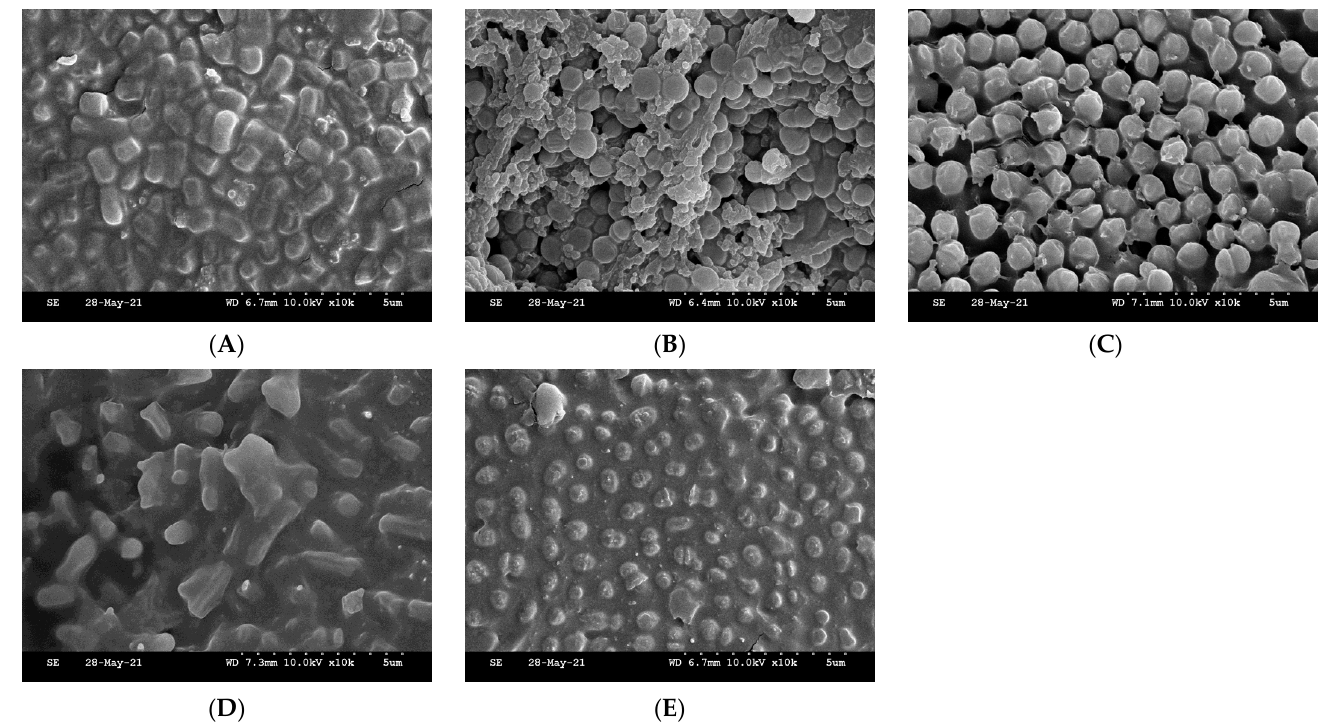
Figure 1. Representative scanning electron micrographs (SEM) at 10,000× of probiotic bacterial cells after freeze-drying owing to the addition of 3% low molecular weight collagen-peptide (LCP). ( A ): Lactoplantibacillus plantarum MG989, ( B ): Lactococcus lactis MG5125, ( C ): Enterococcus faecium MG5232, ( D ): Bifidobacterium animalis ssp. lactis MG741, and ( E ): Streptococcus thermophilus MG5140.